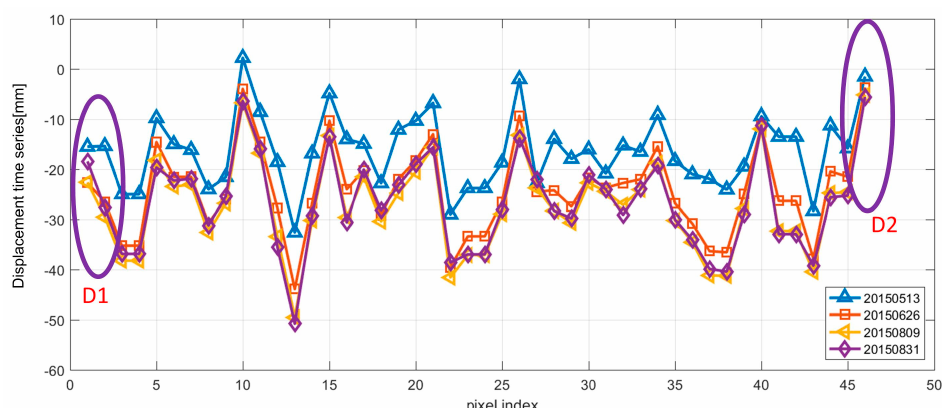
Figure 17. Longitudinal direction displacement profile along D1D2 on Ronguite Bridge.